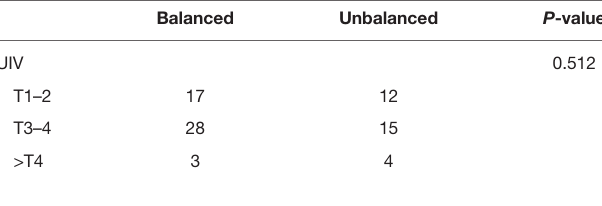
TABLE 2 | The UIV levels of balanced and unbalanced group.